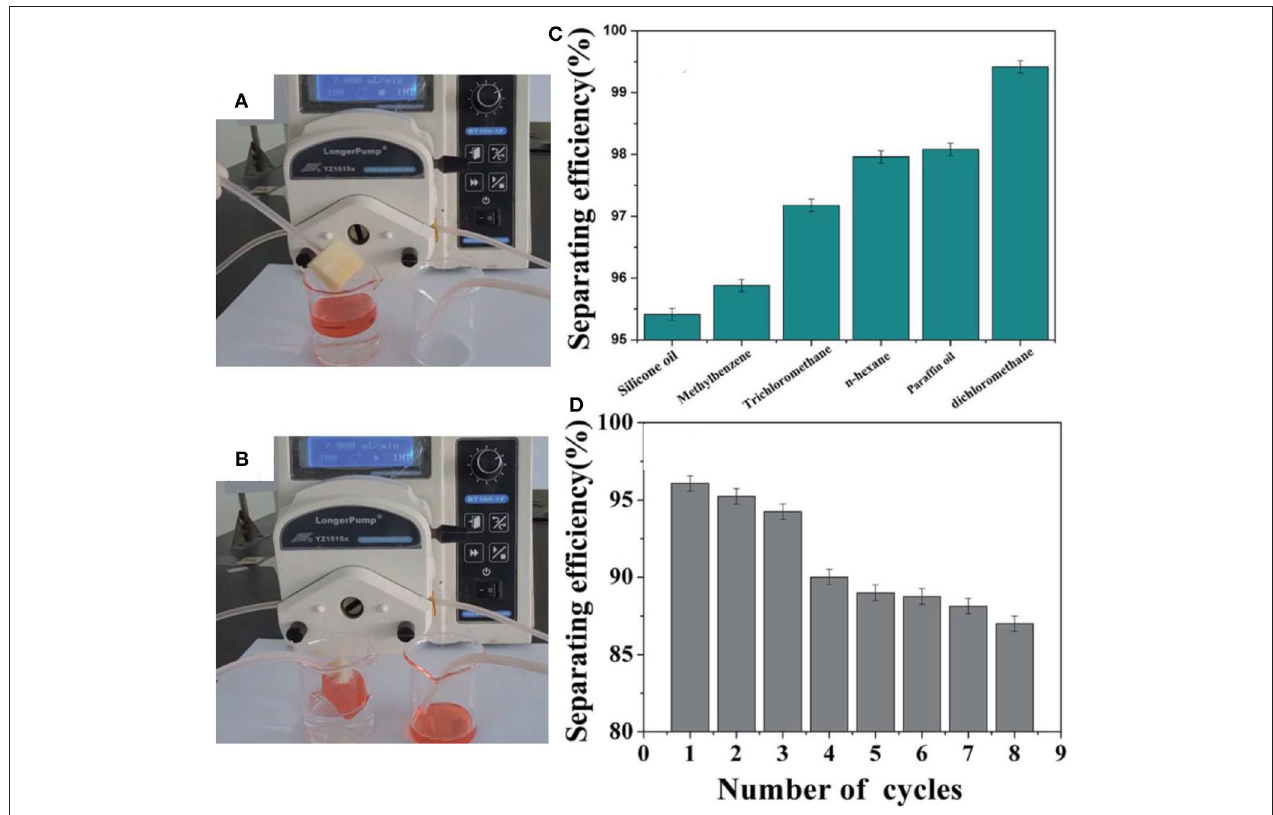
FIGURE 3 | Digital images showing (A,B) the absorption of red-dyed silicone oil. (C) Separating efficiency and (D) recyclability of the sponge. Adapted from Zhi et al. (2017) . With permission from the Royal Society of Chemistry,